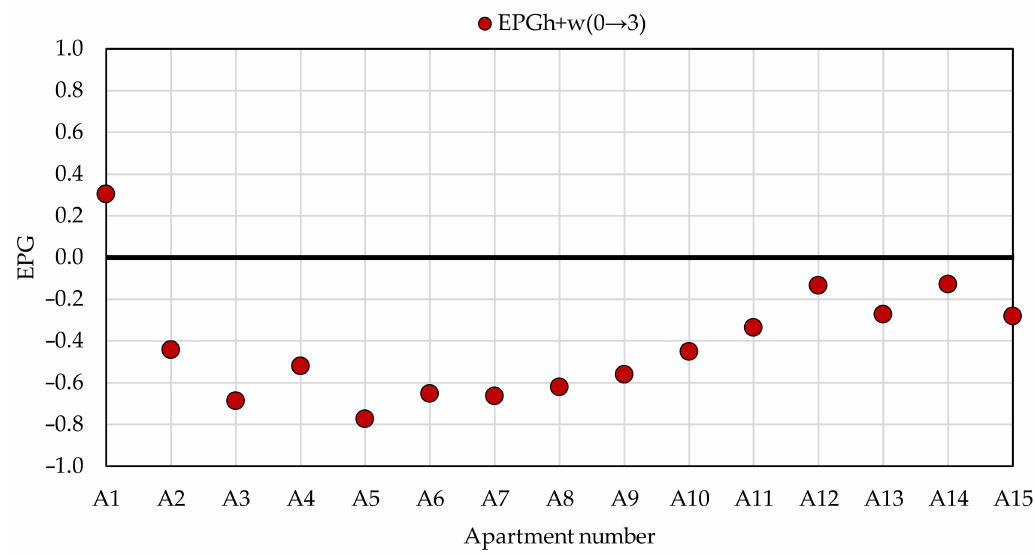
Figure 5. Energy performance gap for heating and DHW preparation.